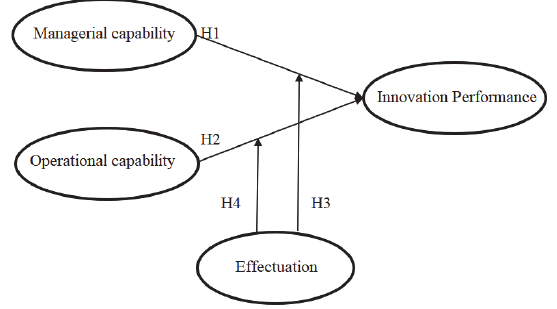
Figure 1. Research